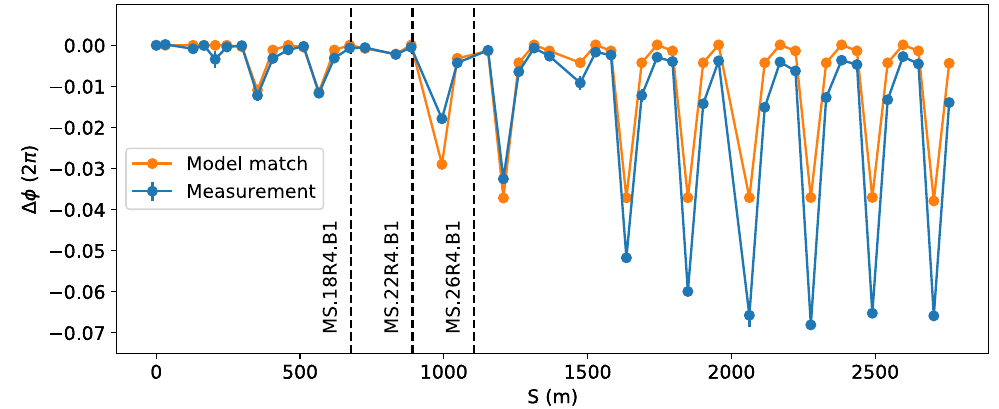
FIG. 18. Horizontal betatron phase-advance deviation from the local model in arc 45. In blue the measurement and in orange the effect of the local correction with orbit bumps in sextupoles. The sextupoles where the bump reached its peak are